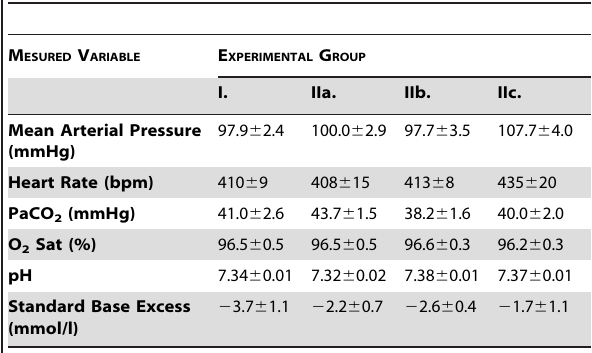
Table 1. Baseline physiological parameters in the different in vivo experimental groups.